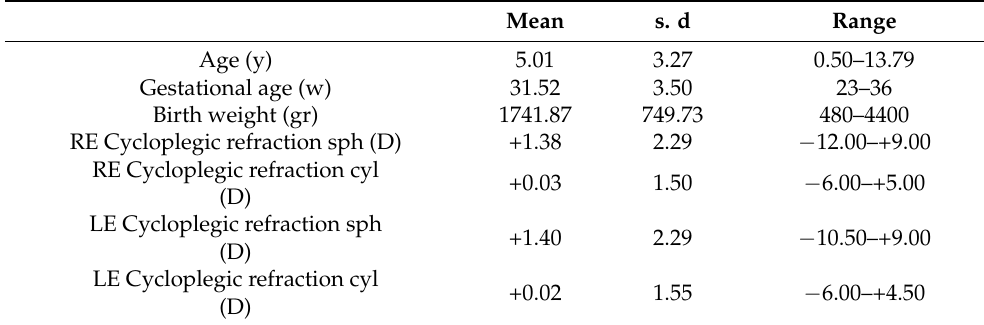
Table 3. Pre group